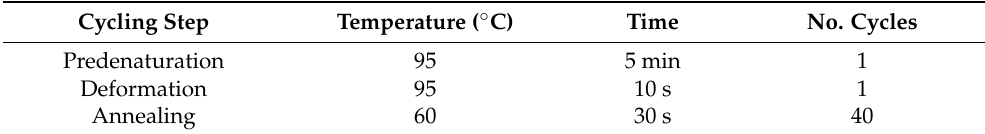
Table 1. qRT-PCR conditions and parameters.